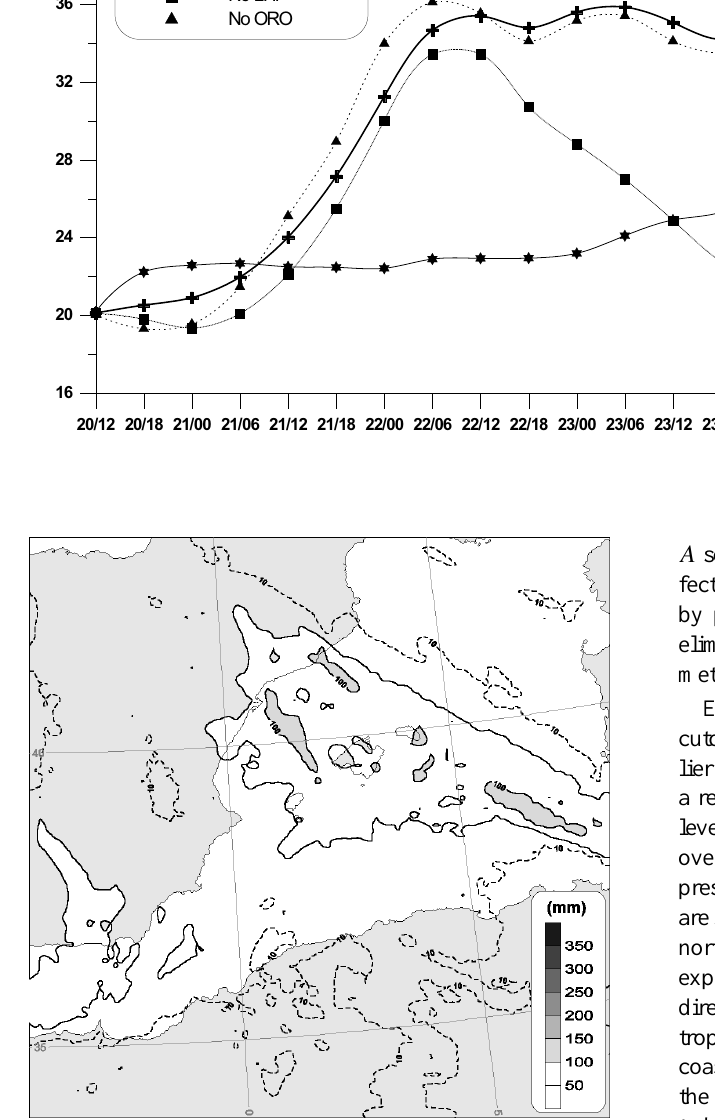
Fig. 20. As in Fig. 7c but for the non-orographic